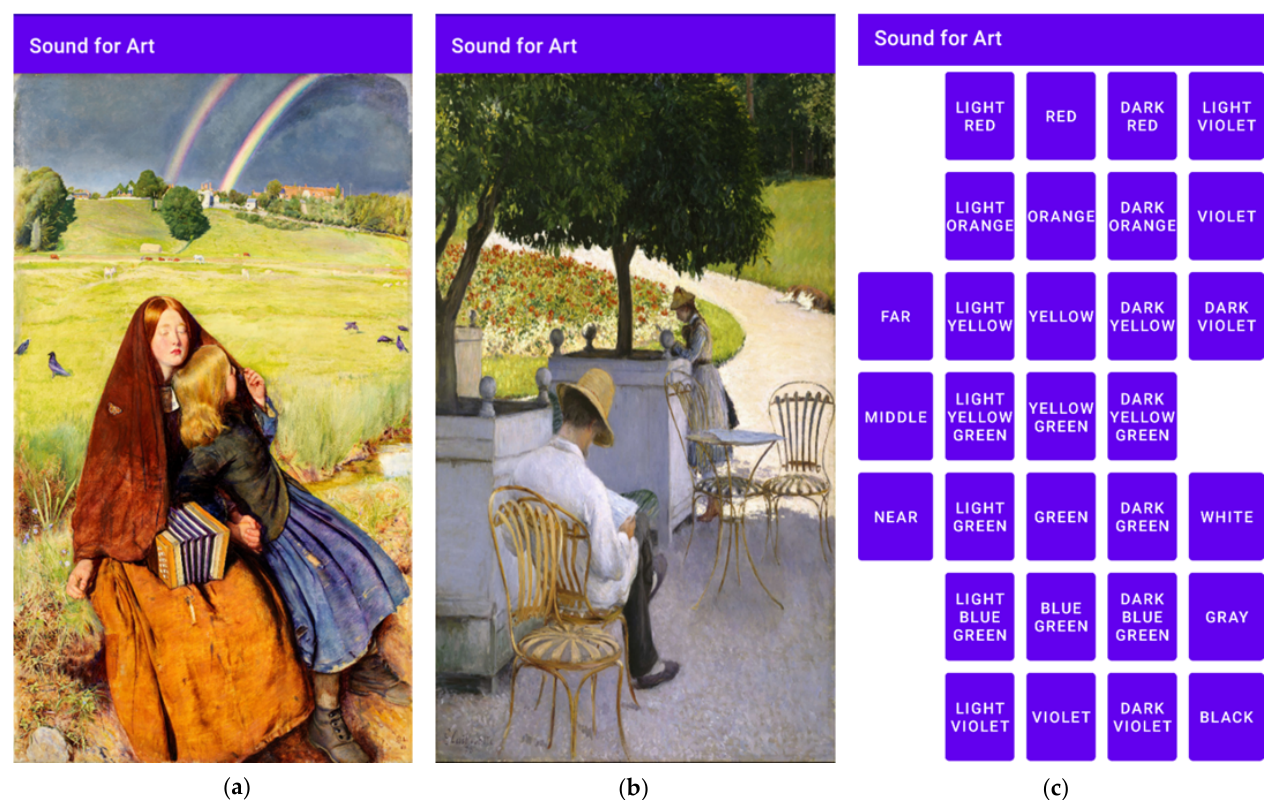
Figure 6. Application interface. ( a ) The Blind Girl interface; ( b ) The Orange Trees interface; ( c ) test interface.